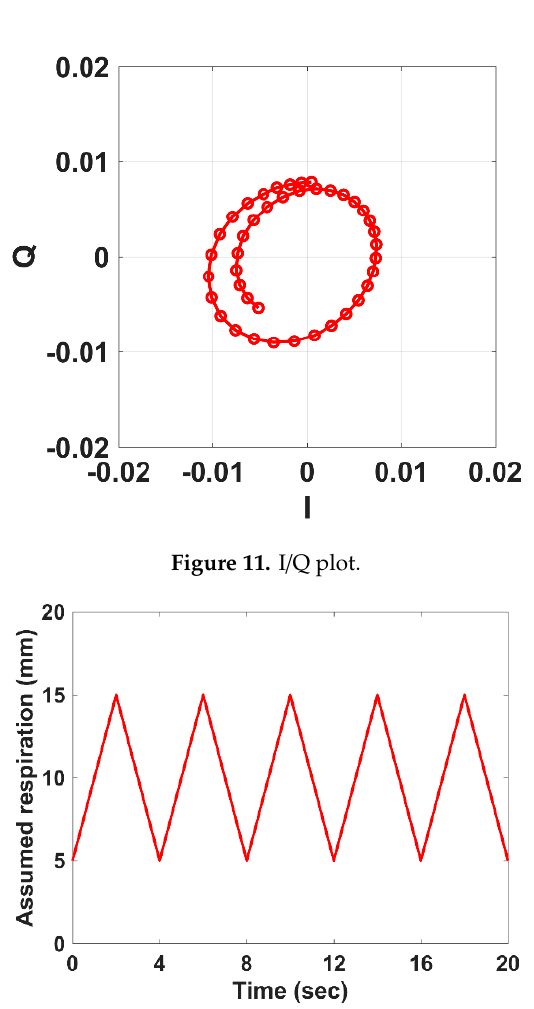
Figure 10. Amplitude and phase of the signal returned from the phantom: ( a ) amplitude; ( b ) phase.